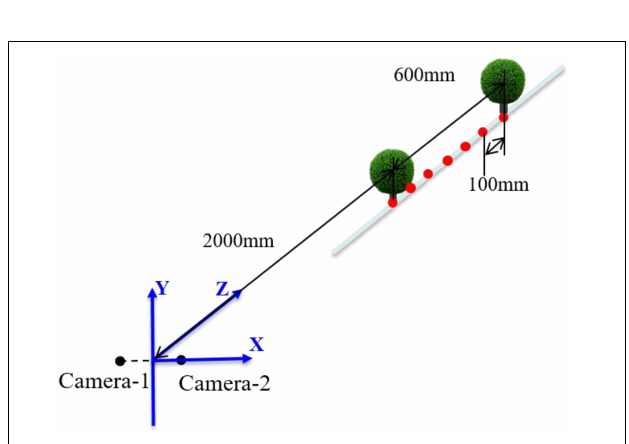
FIGURE 17 | Schematic diagram of laboratory test.